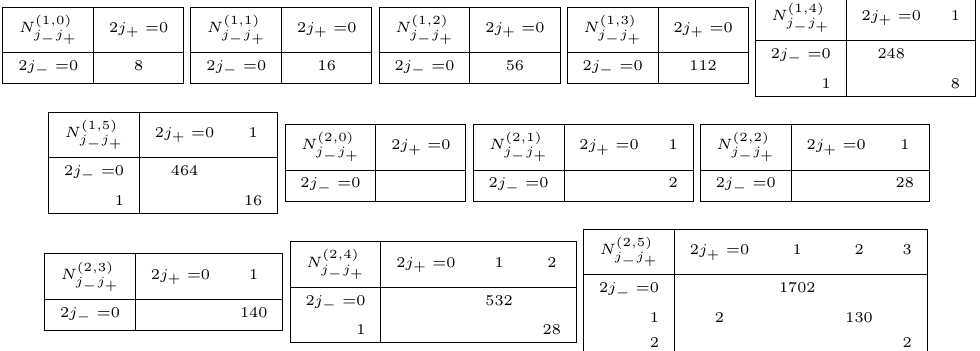
Table 11 . Re(cid:12)ned BPS invariants N ( b;d )